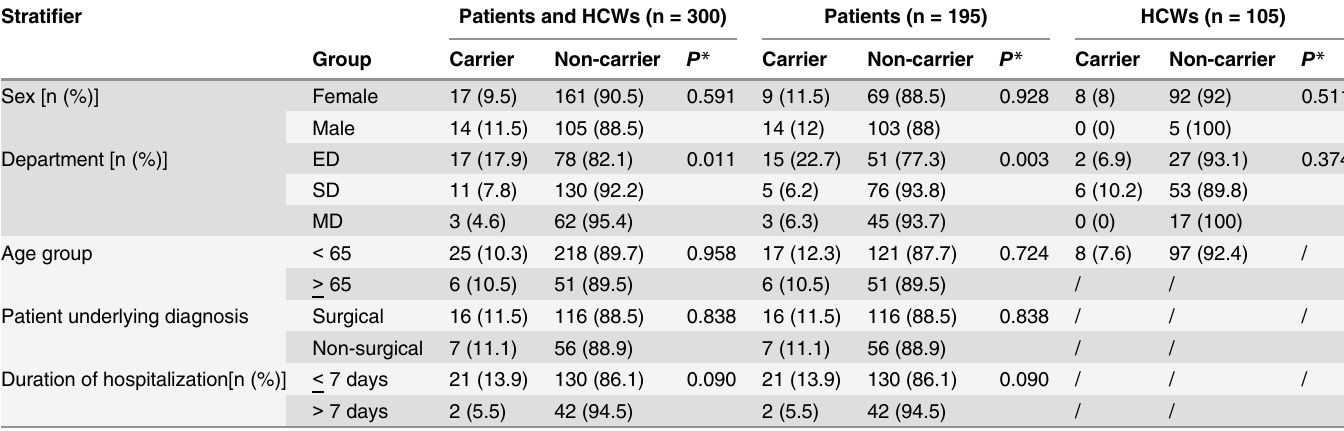
Table 2. Distribution of methicillin-resistant Staphylococcus aureus (MRSA) carriers and non-carriers among patients and healthcare workers (HCWs) stratified by department, sex, age group, patient underlying diagnosis and duration of hospitalisation at the Clinical Centre of Serbia,